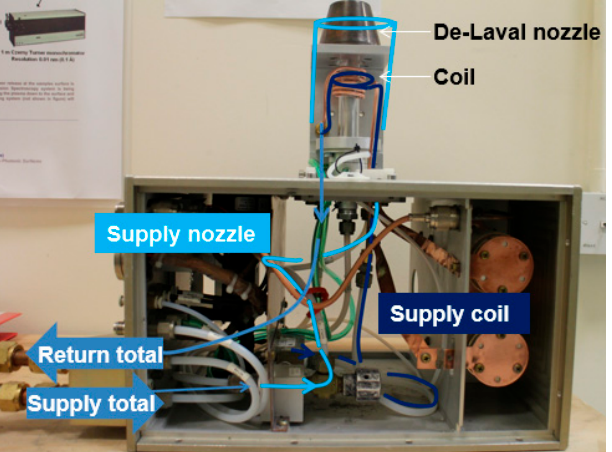
Figure 4. Torch assembly: plasma torch, coolant circuit, and fixed match RF network.